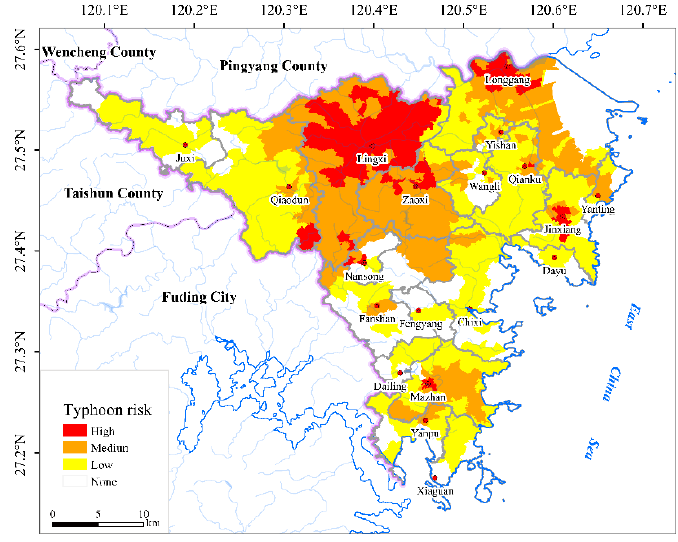
Figure 5. Spatial pattern of comprehensive typhoon risk in Cangnan County.